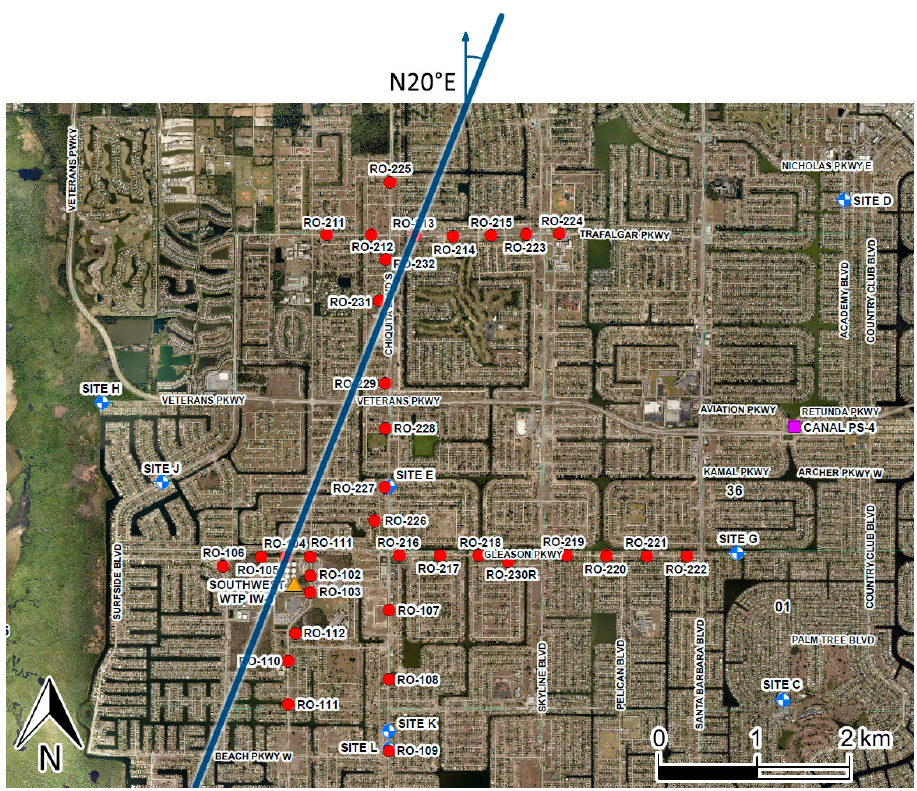
Figure 15. Approximate location of fracture zone or fault that impacts water quality in the wellfield.